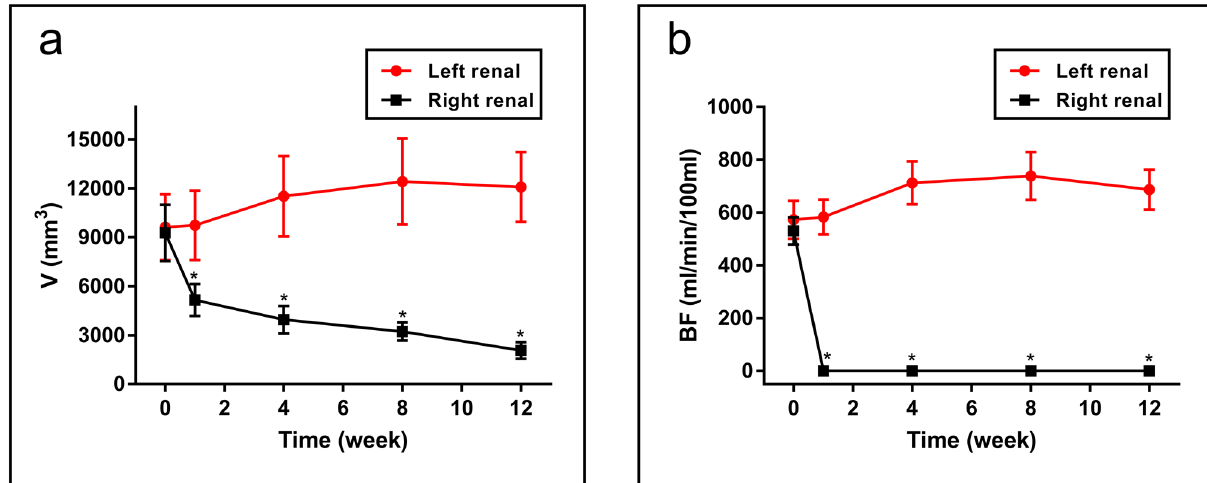
Figure 3. Morphological and hemodynamic changes of the two kidneys of a rabbit at various time points. ( a ) Changes in volume: individual renal volumes were measured using the ellipsoid formula (volume = length × width × thickness × π/6). ( b ) Changes in BF. * P < 0.0001 versus the pre-treatment.